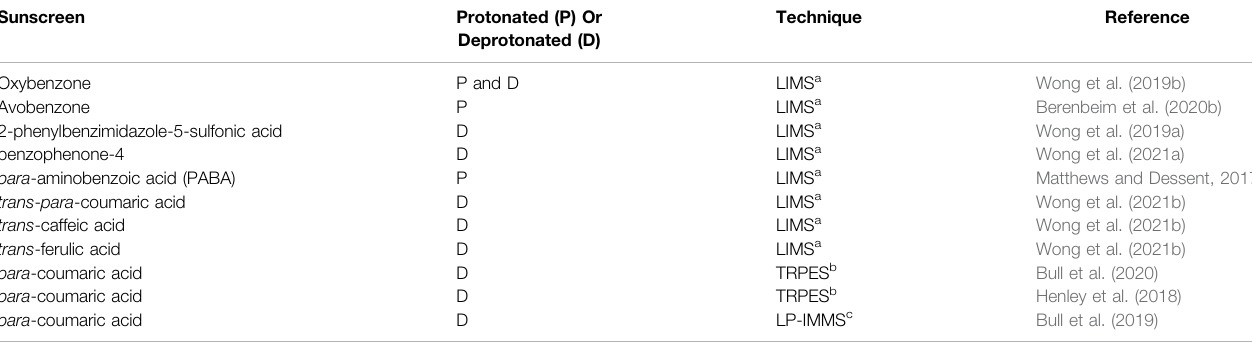
TABLE 1 | Summary of Isolated (Gas-Phase) Sunscreen Molecules Studied in their Protonated or Deprotonated Forms. Sunscreen Protonated (P) Or Deprotonated